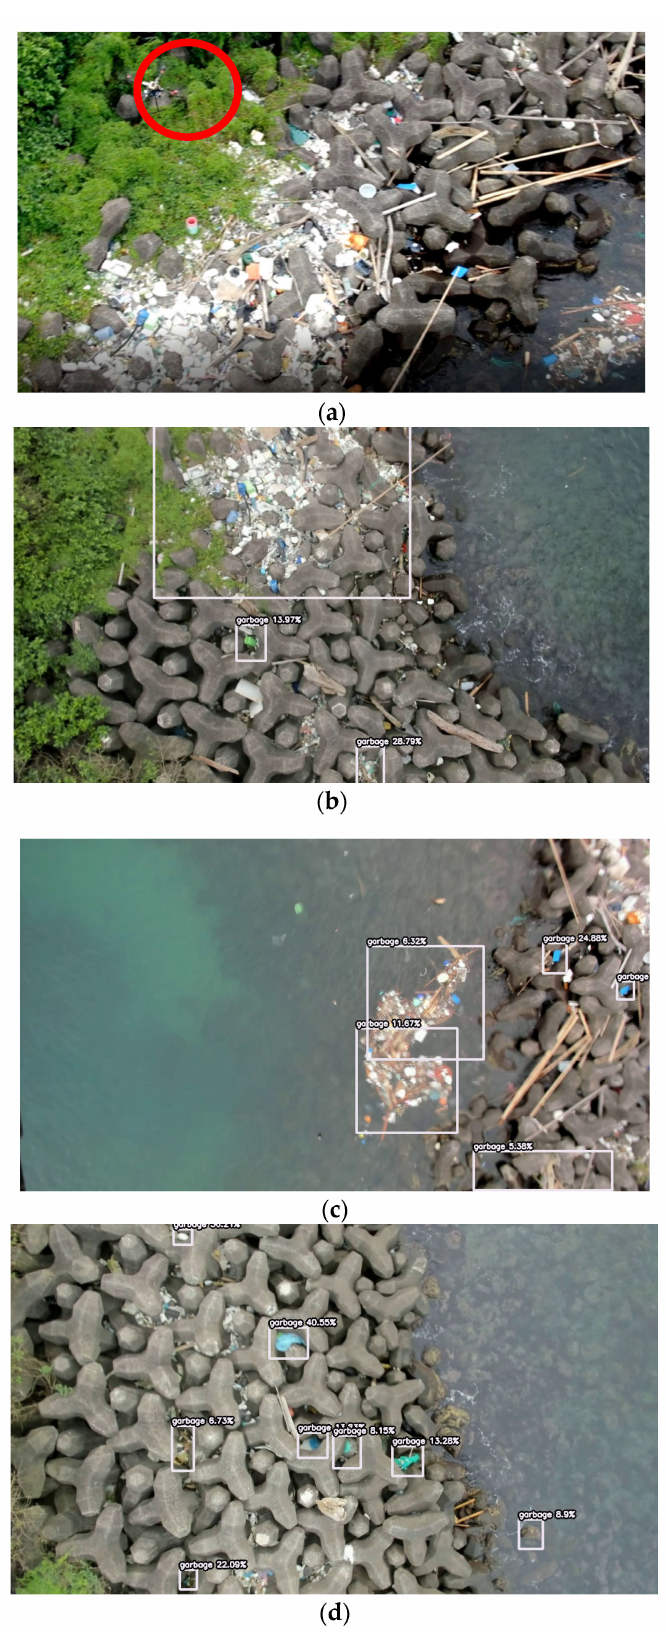
Figure 13. Trash detection at the Badouzi fishing port. ( a ) Real-world UAV test in Badouzi. ( b ) The detection result of the trash detector at location 1. ( c ) The detection result of the trash detector at location 2. ( d ) The detection result of the trash detector at location